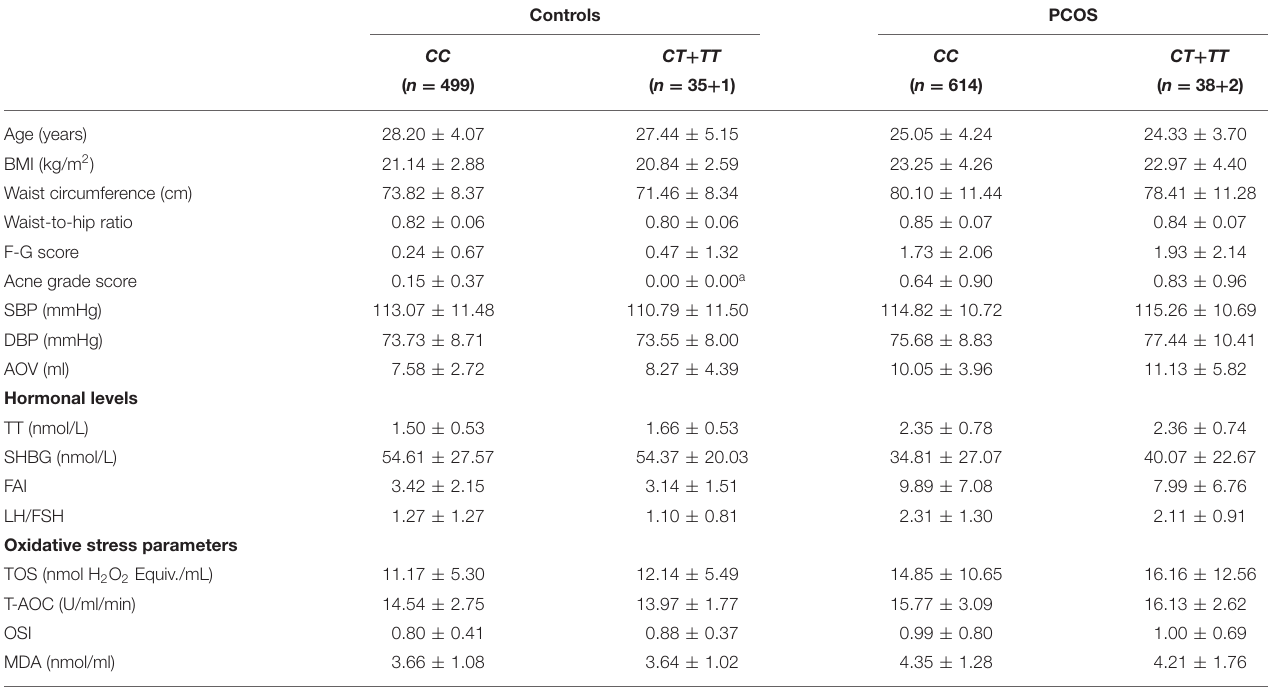
TABLE 5 | Clinical characteristics, hormonal levels, and oxidative stress parameters of the CAT C-262T genotypes in PCOS patients and controls.